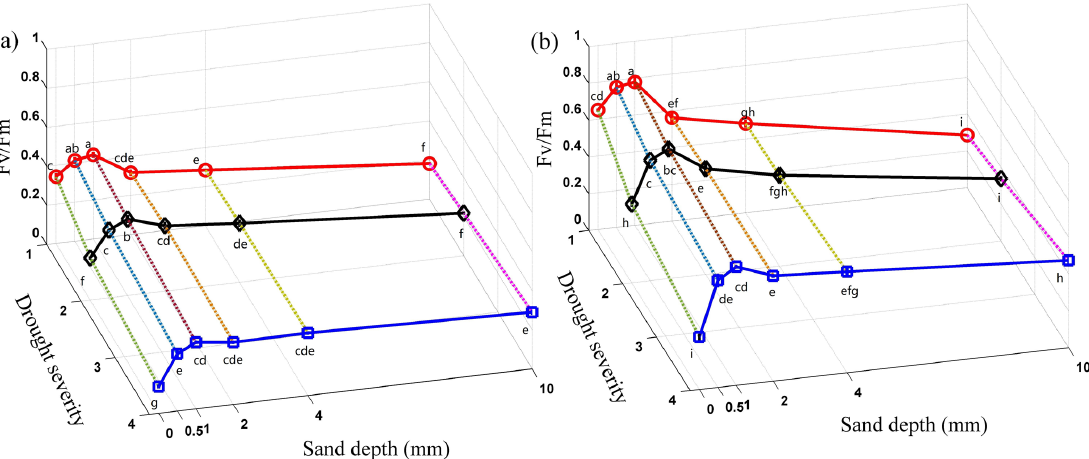
Figure 3. Changes in the PSII photochemical efficiency (Fv / Fm) of the biocrust moss Bryum argenteum Hedw. following exposure to natural precipitation (control; 1), half of the natural precipitation amount (2), and one-fourth of the natural precipitation amount (4), combined with 0 (control), 0.5, 1, 2, 4, and 10mm depth of sand burial in spring (a) and autumn (b) . Symbols represent means ± SE. Different letters indicate significant differences between different drought severities and sand burial depth treatments at the p < 0 . 05 level as determined using an LSD post hoc